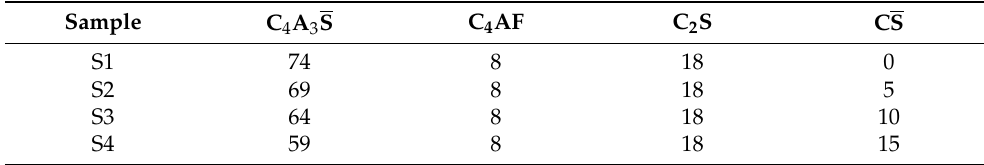
Table 2. Design mineral composition of cement clinker (wt.%).